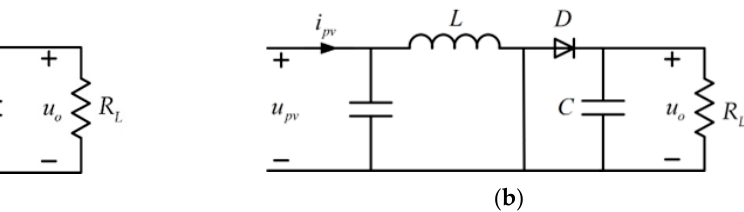
Figure 4. Equivalent circuit schematic of boost circuit in two working modes. ( a ) Equivalent circuit when the switch is off in the boost circuit; ( b ) Equivalent circuit when the switch is on in the boost circuit.